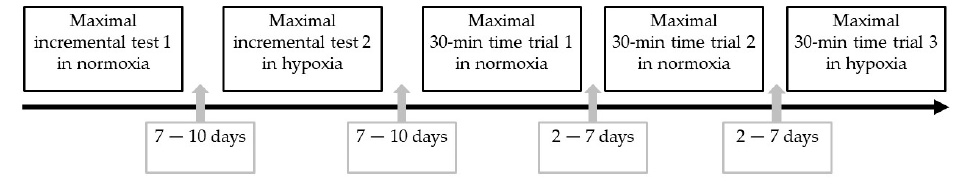
Figure 1. Experimental design including the sequence of the tests and the breaks between tests.